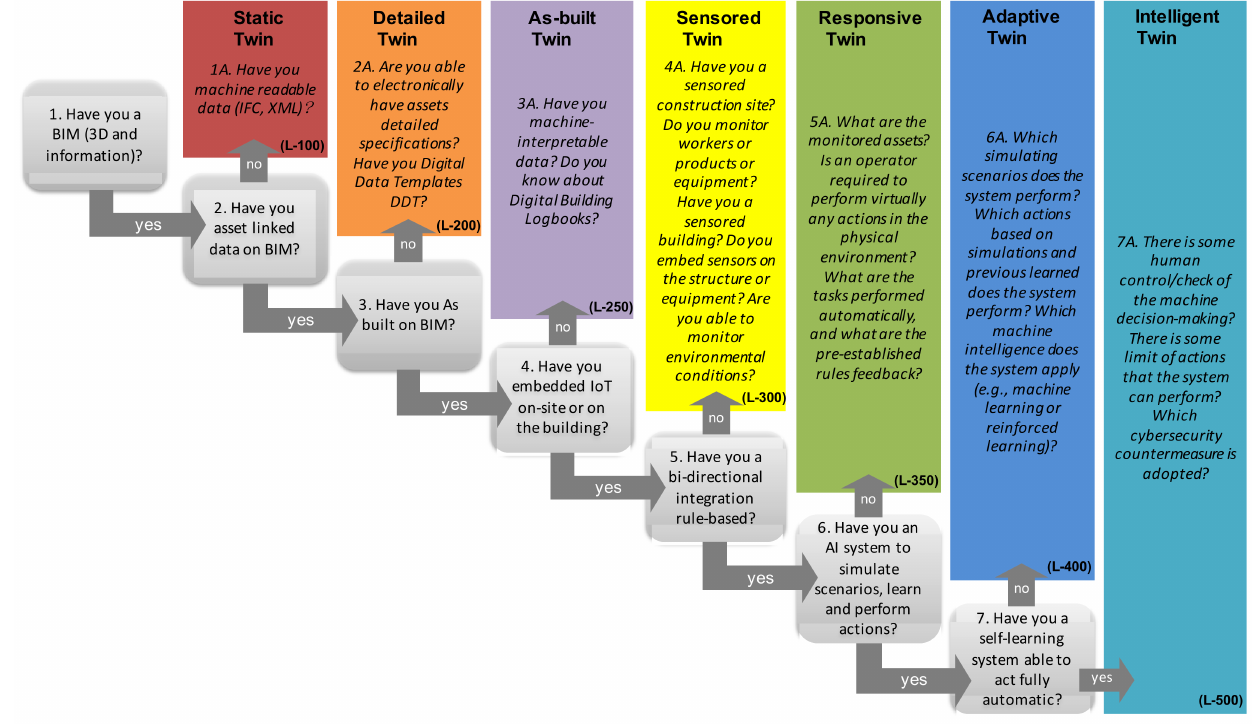
Figure 6. DTC incremental maturity levels diagnosis framework